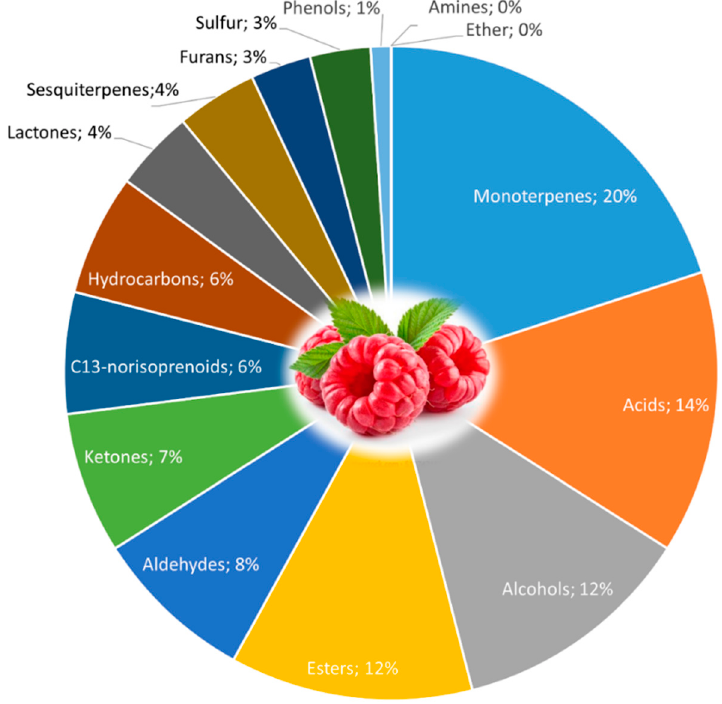
Figure 5. Volatile compounds in raspberry fruit ( Rubus idaeus L.) and their chemical class. Adapted from [172].